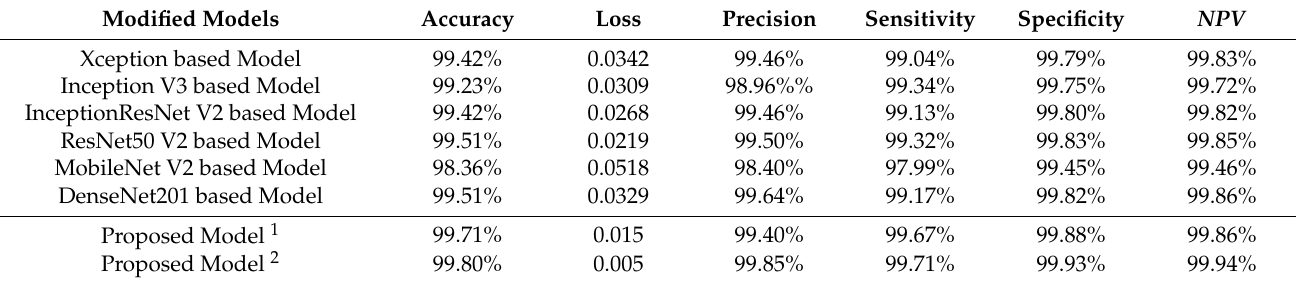
Table 14. Evaluation Models’ performance based on metrics scoring.